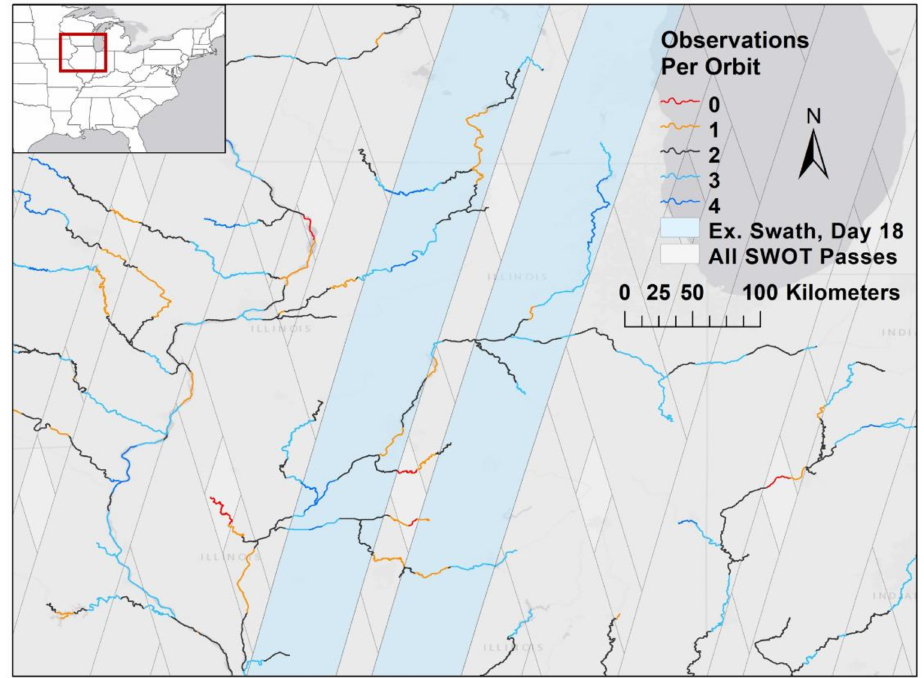
Figure 1. An example of SWOT observable rivers near the lake Michigan (dark gray) and Illinois area of the United States. The rivers are colored by the number of observations per 21-day orbit cycle per 10 km reach. SWOT swaths are visible in the background with a specific swath in blue to better visualize the layout of a single pass on day 18 of the cycle. Each pass consists of two 50 km